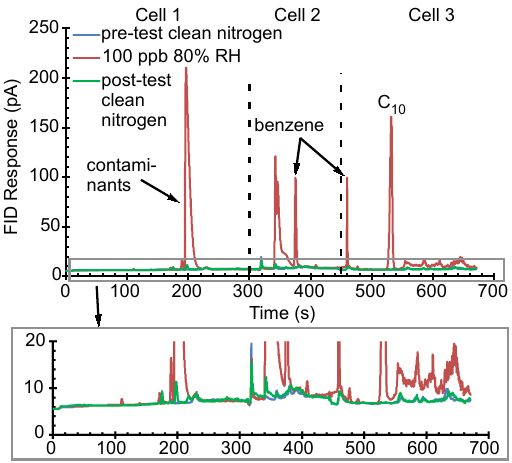
Figure 11. The PCA3mv chromatogram of the bracket test with 3 consecutive analytical cycles. Cycle: clean nitrogen. Cycle 2: IPA, benzene, C 10 at 80% relative humidity. Cycle 3: clean nitrogen. Cycle 3 showed almost the same chromatogram as Cycle 1, indicating minimal sample carryover.